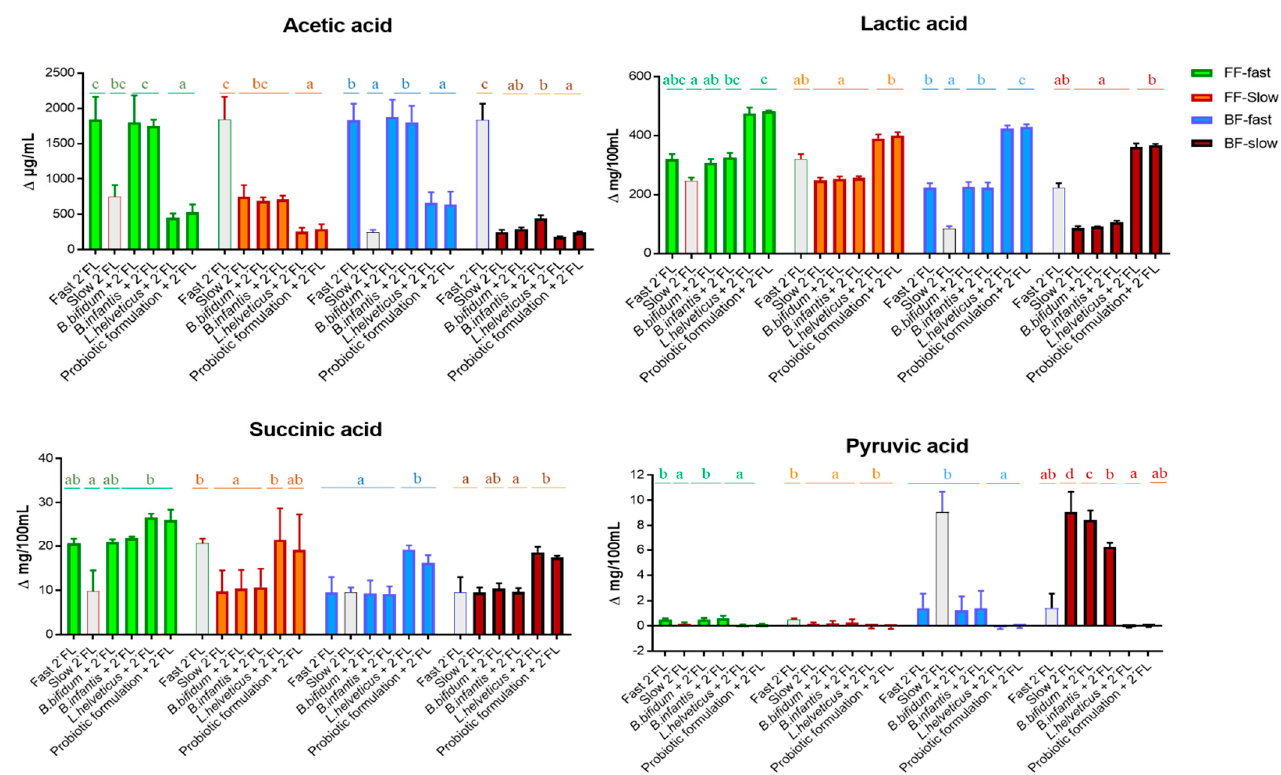
Figure 3. Variations after 24 h of incubation with respect to baseline (time 0) in the levels of microbial metabolites displaying any significant difference (acetic, lactic succinic, and pyruvic acid) between fecal cultures with 2 (cid:48) FL and added probiotics and the corresponding cultures only with 2 (cid:48) FL. Different letters on the horizontal lines above the bars indicate significant differences ( p < 0.05) among the different conditions, analyzed separately in cultures of FF and BF infant fast and slow degraders. Bars shaded in grey correspond to cultures with different 2 (cid:48) FL velocities of degradation but the same mode of feeding as the group being analyzed and were considered for statistical comparisons with the group next to which they are placed in each case in the figure. Values for fast- and slow-degrading cultures with added 2 (cid:48) FL without probiotics have been published previously [7] and are used here for statistical comparisons .